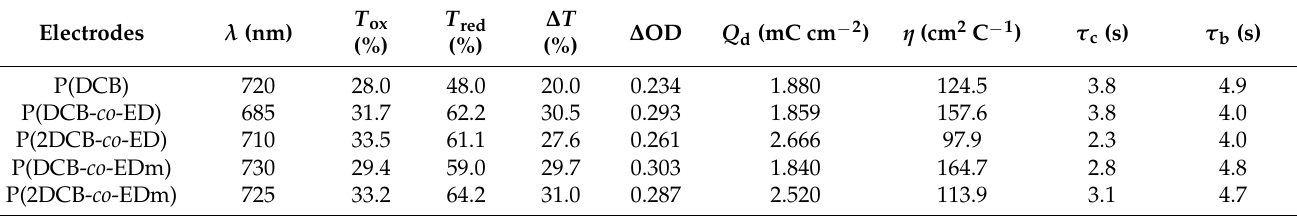
Figure 6. Switching profiles of the ( a ) P(DCB), ( b ) P(DCB- co -ED), ( c ) P(2DCB- co -ED), ( d ) P(DCB- co - EDm), and ( e ) P(2DCB- co -EDm) electrodes. Table 3. Chromic parameters of electrodes.